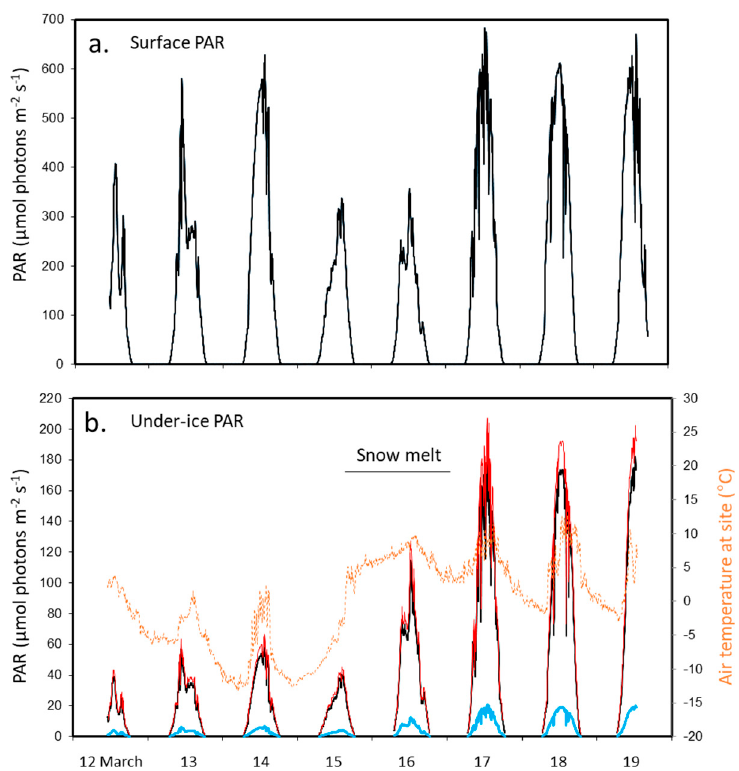
Figure 6. Surface downwelling PAR ( a ), and under-ice PAR between 12 and 19 March (black full line), 10% upwelling PAR (blue full line), the sum of upwelling and downwelling (red full line), and air temperature at 1.0 m above the surface (dotted orange line) ( b ), with snow melt period indicated.